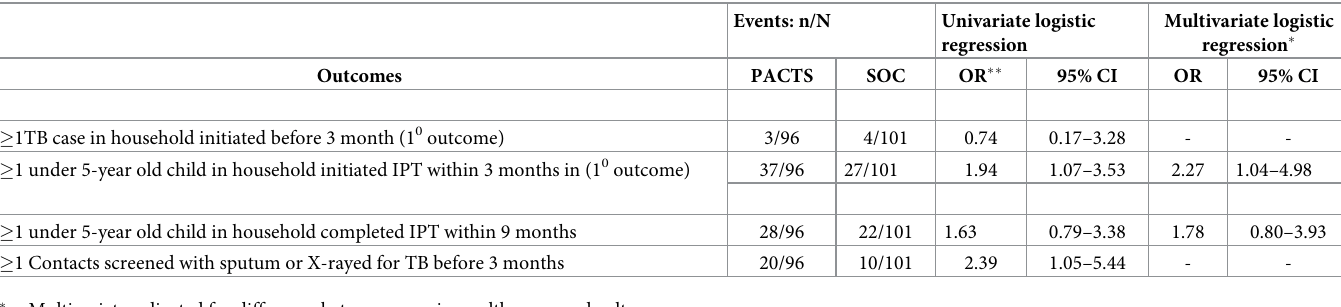
Table 3. Primary and secondary outcomes by trial arm, at